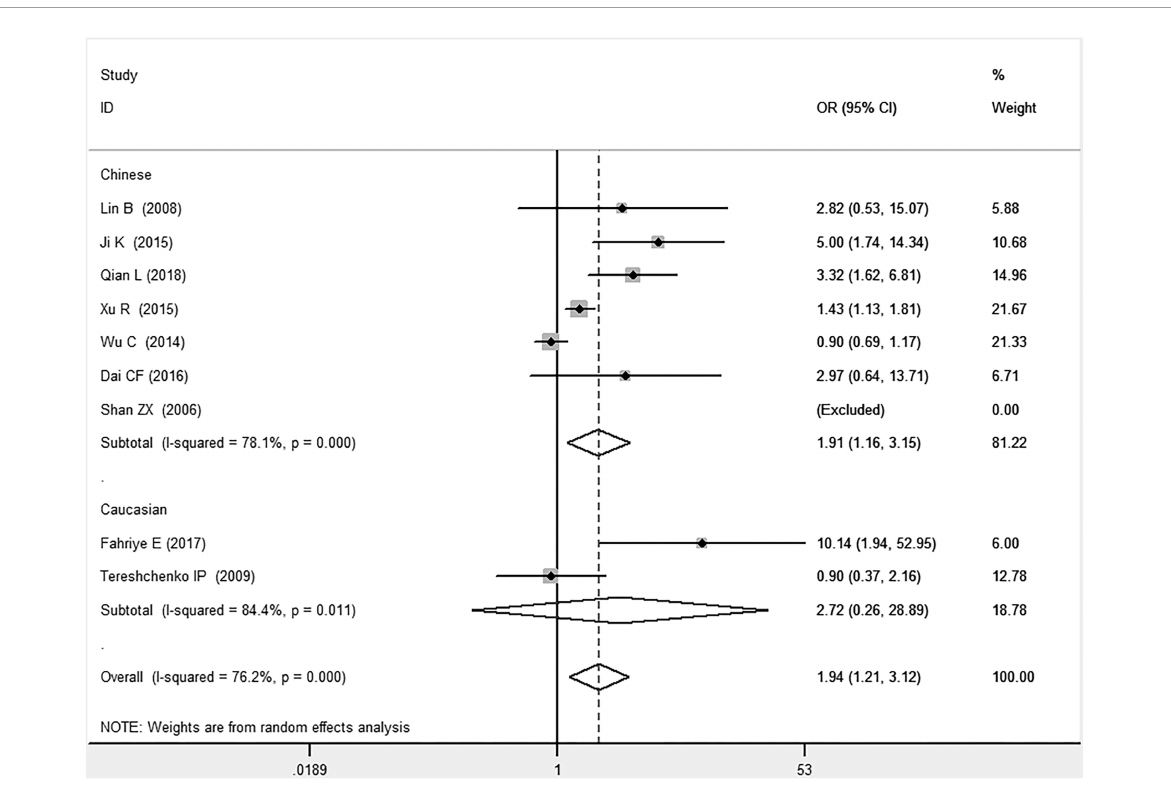
FIGURE2 Forest plot of CAD associated with MIF gene rs755622 G/C polymorphism under a recessive genetic model (i.e., CC vs. GG + GC of MIF gene rs755622 G/C